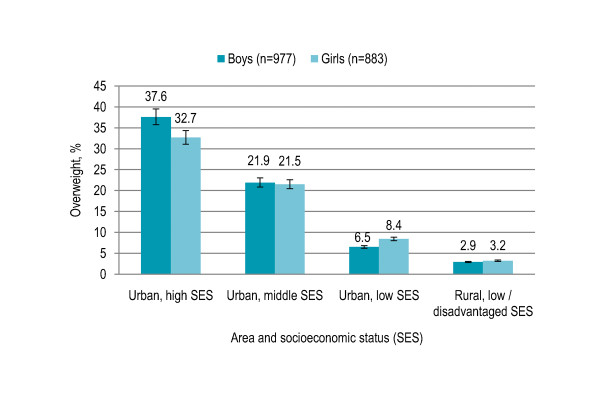
Gender-specific prevalence (with confidence interval bars) of overweight by area and socioeconomic status among primary school children in Lahore, Pakistan (n = 1860).